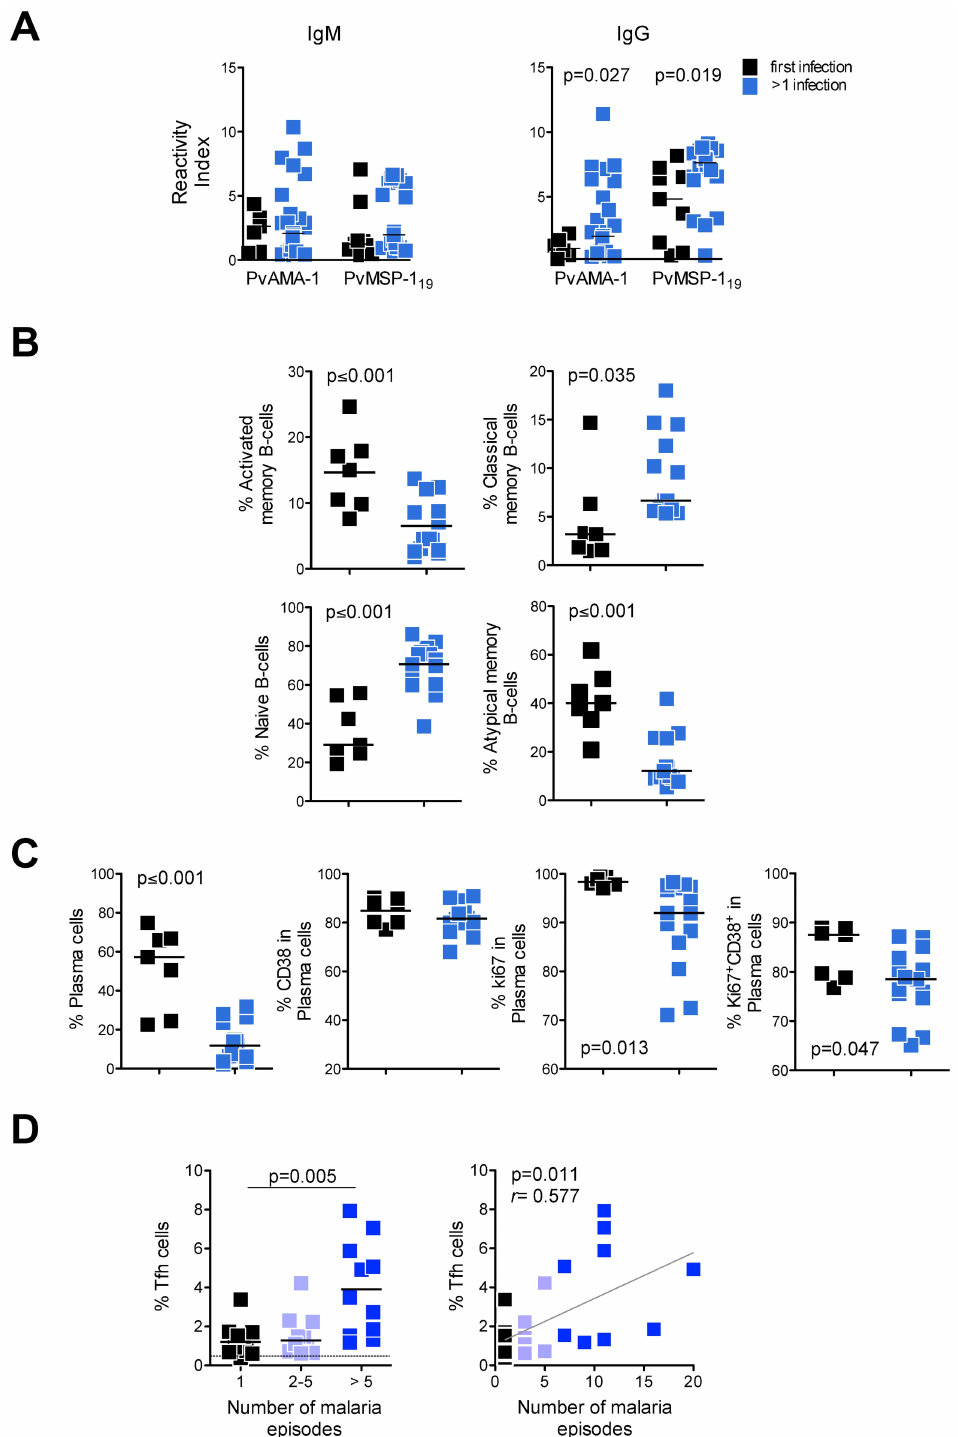
Fig 6. Repeated Plasmodium vivax exposures increasethe levels of antigen-specific IgG. A-C. Components of humoral responsewere measuredin patients acutely infected for the first time (black squares) or with multipleinfections(blue squares)with P . vivax . A. Pv AMA-1 and PvMSP-1 19 IgM and IgG were measurein plasma. B. Scattered plots showingfrequency of activated memory (CD27 + CD21 - ), classical memory (CD27 + CD21 + ), na ï ve(CD27 - CD21 + ) and atypical memory (CD27 - CD21 - ) B cells in P . vivax